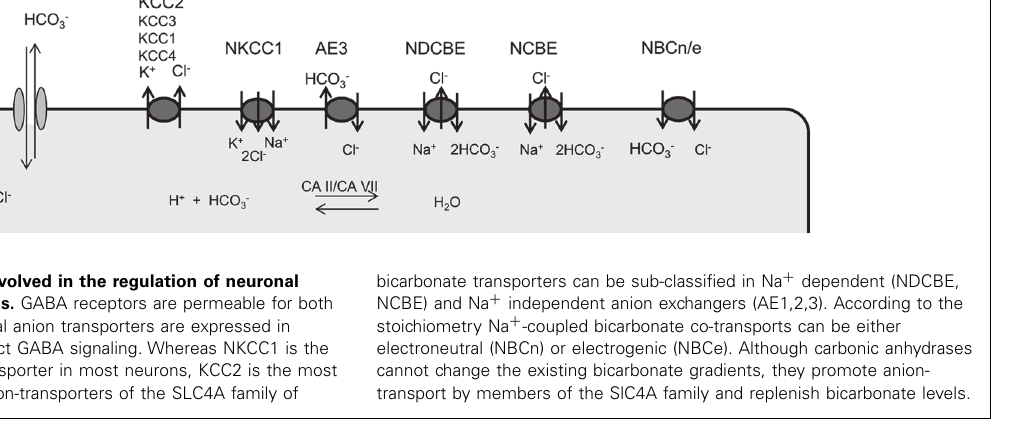
Frontiers in Cellular